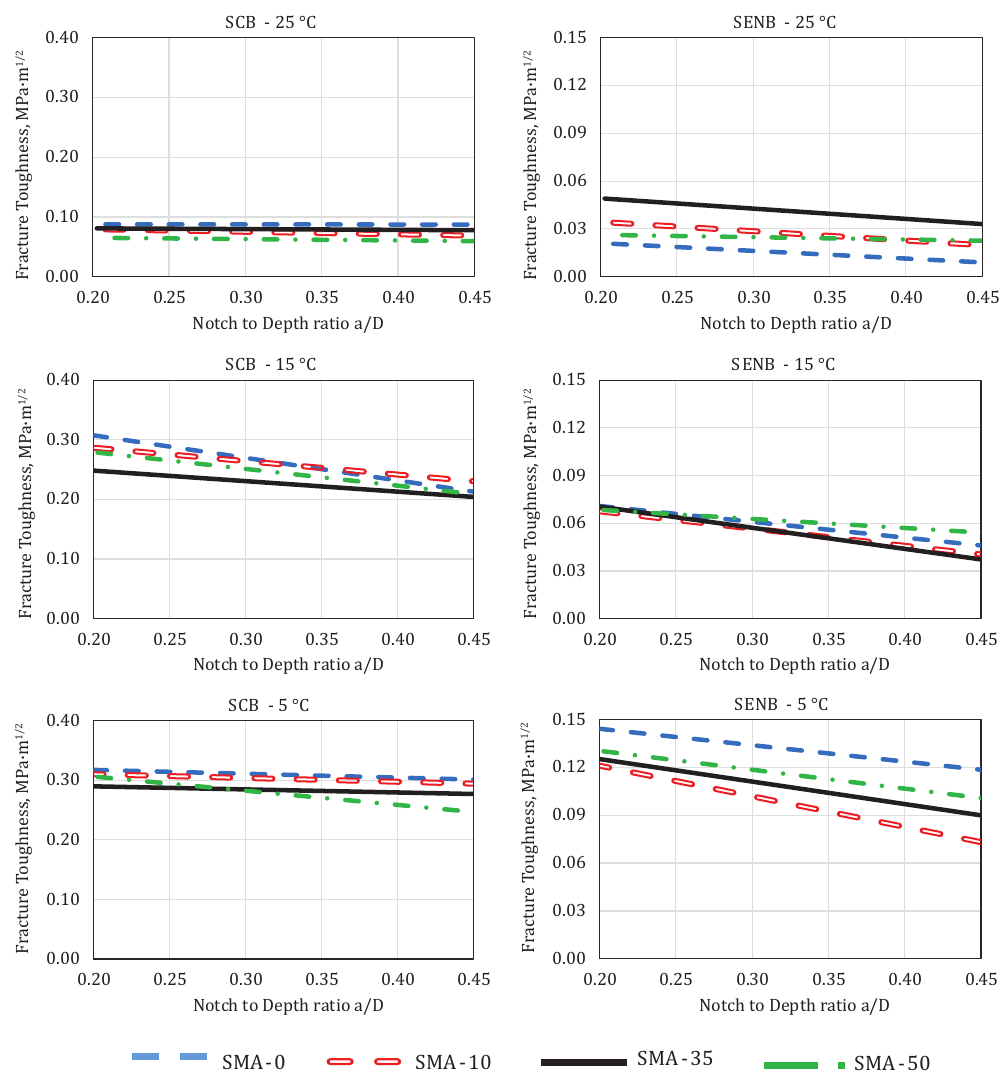
Figure 13. Fracture toughness vs. notch depths (a) 25 °C; (b) 15 °C; (c) 5